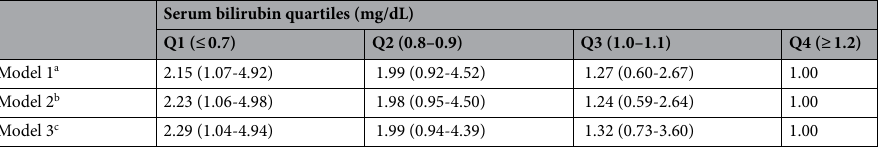
Table 2. Odds ratios and 95% confidence for testosterone deficiency according to serum bilirubin quartiles. a Adjusted for age. b Adjusted for age, fasting plasma glucose, and triglyceride. c Adjusted for age, fasting plasma glucose, triglyceride, HDL-cholesterol, leukocyte count, hemoglobin, smoking status, and alcohol